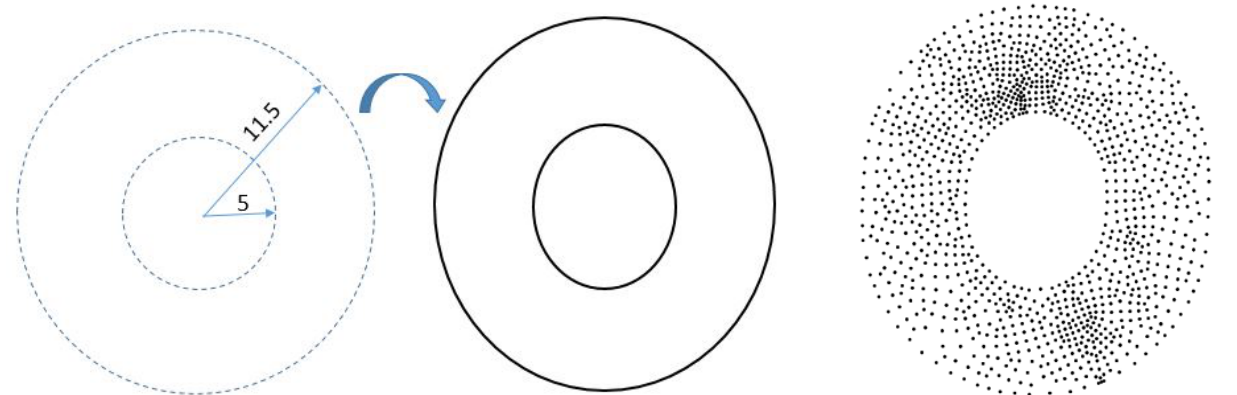
Figure 10. Crushed Ring Sample. The figure on the left shows the sample geometry for crushed ring steel sample before and after applying force (all dimensions are in mm). The figure on the right shows a node set containing N = non-uniform spaced nodes on the crushed ring sample.